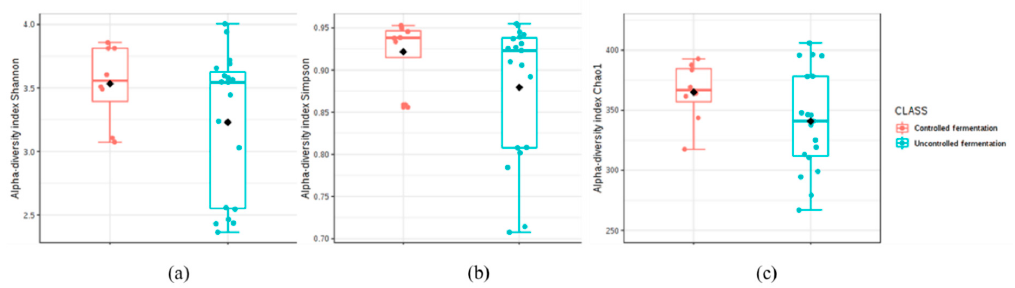
Figure 3. The Shannon ( a ), Simpson ( b ) and Chao1 ( c ) diversity indices of chicha communities regarding the controlled and uncontrolled fermentation experimental groups. The interquartile range is represented by the outer bounds of the boxes, the median is represented by the midline and the outliers are represented by the circles. The whiskers represent the minimum and maximum